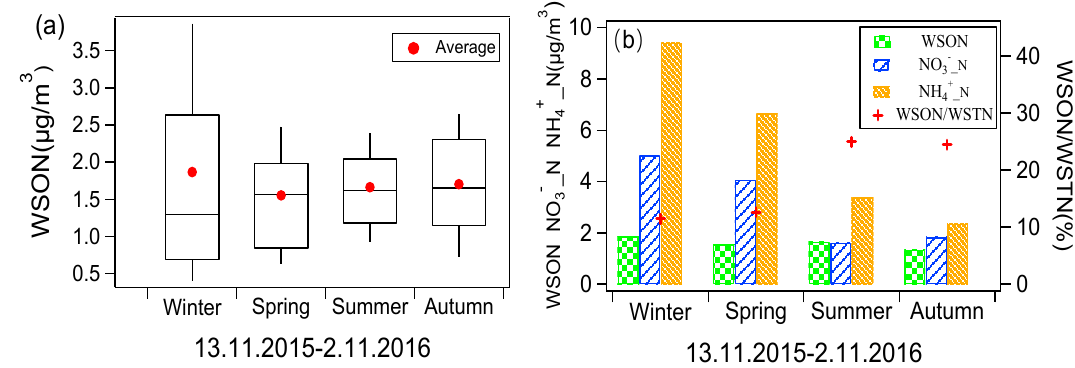
Figure 7. Seasonal average concentrations of WSON ( a ), and average concentrations of WSON, nitrogen in ammonium (NH 4+ _N) and nitrate (NO 3 − _N), and WSON/water-soluble total nitrogen (WSTN) (%) ( b